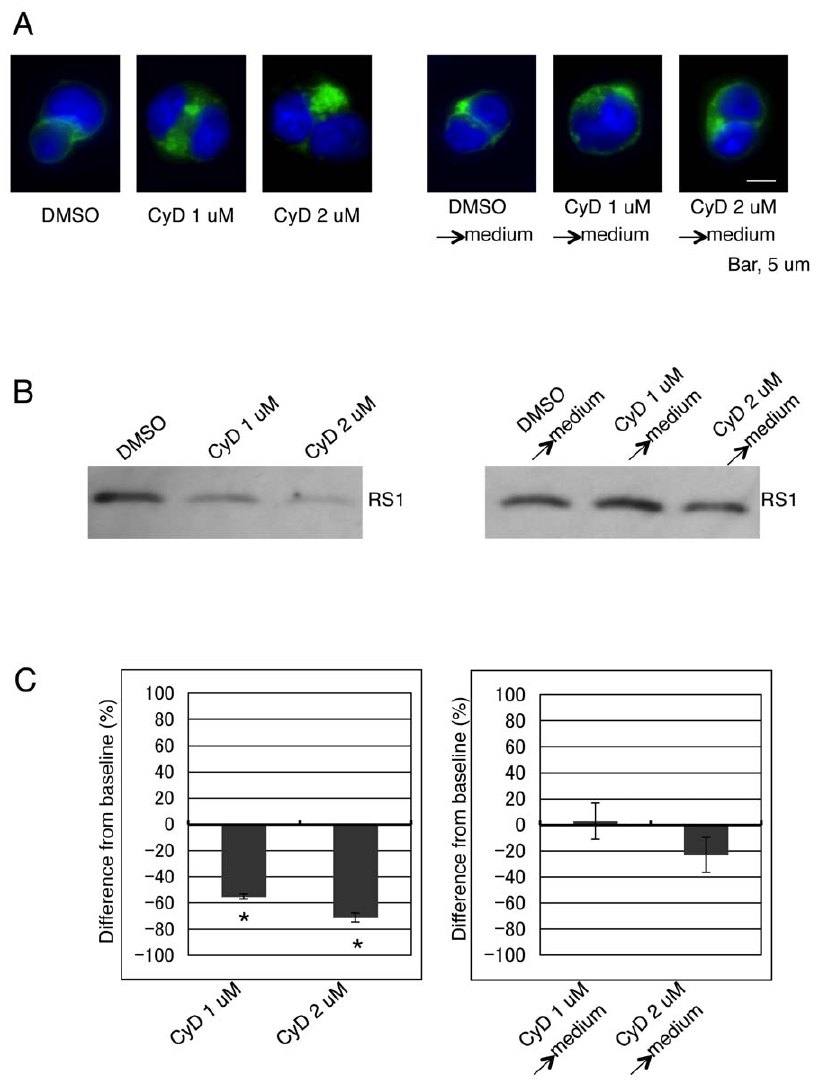
Figure 3. The effect of cytochalasin D on retinoschisin secretion is reversible. (A) F-actin cytoskeleton organization visualized with Alexa Fluor 488-phalloidin (green). Duplicate cell samples were treated with DMSO or 1 m M and 2 m M cytochalasin D (CyD) for 72 hr. One of the sets of cells was then fixed and labeled for F-actin (left panel). The conditioned medium of the duplicate set of samples was replaced by fresh medium without DMSO (DMSO R medium) or cytochalasin D (CyD 1 or 2 m M R medium) in it. Cells were incubated for another 72 hr in the fresh medium, fixed and labeled with Alexa Fluor 488-phalloidin. (B) Western blot of proteins from the medium of each sample described in (A). Retinoschisin was detected using the RS24-37 antibody. (C) Quantification of the intensity of each band on the Western blot in (B) (see MATERIALS AND METHODS). The data are means 6 SEM of three different biological samples for each condition. *: p , 0.05 was obtained for the difference between 1 m M or 2 m M cytochalasin D- and DMSO-treated